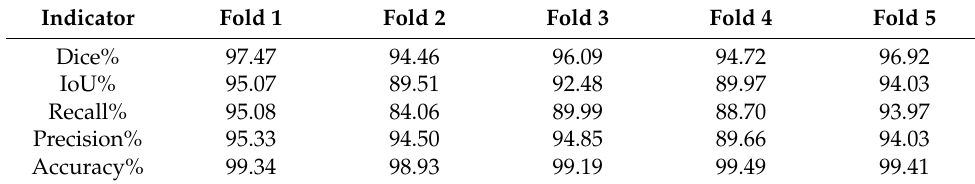
Table 2. 5-fold cross-validation of